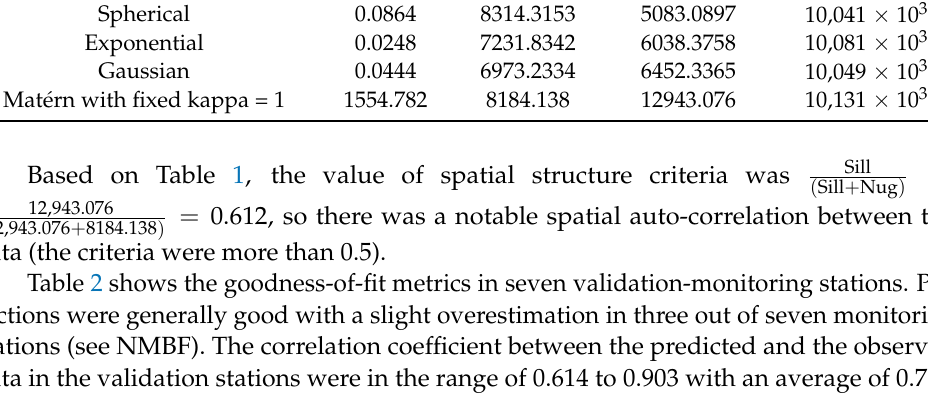
Table 1. The results of the fitted trace-variogram models using various auto-correlation structures. Model Range Nug Sill SSE